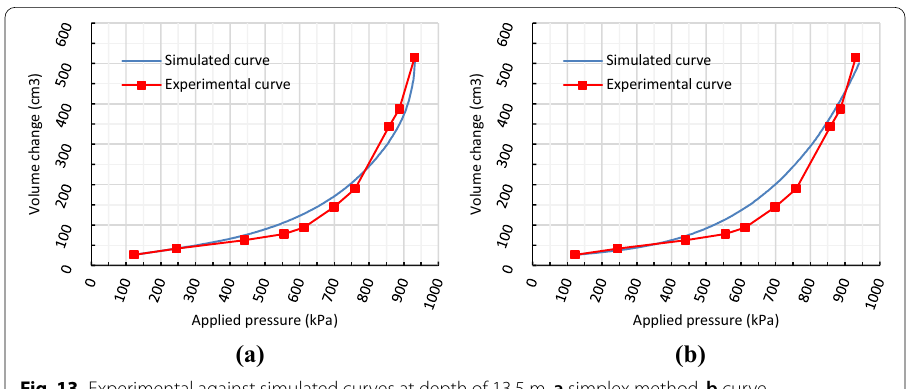
Fig. 13 Experimental against simulated curves at depth of 13.5 m, a simplex method, b curve decomposition method